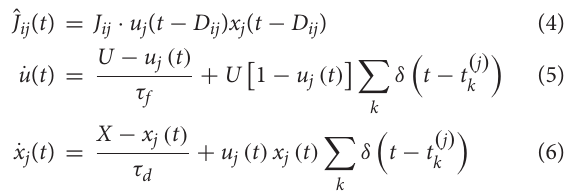
Figure 1E . The range of DA was set as D